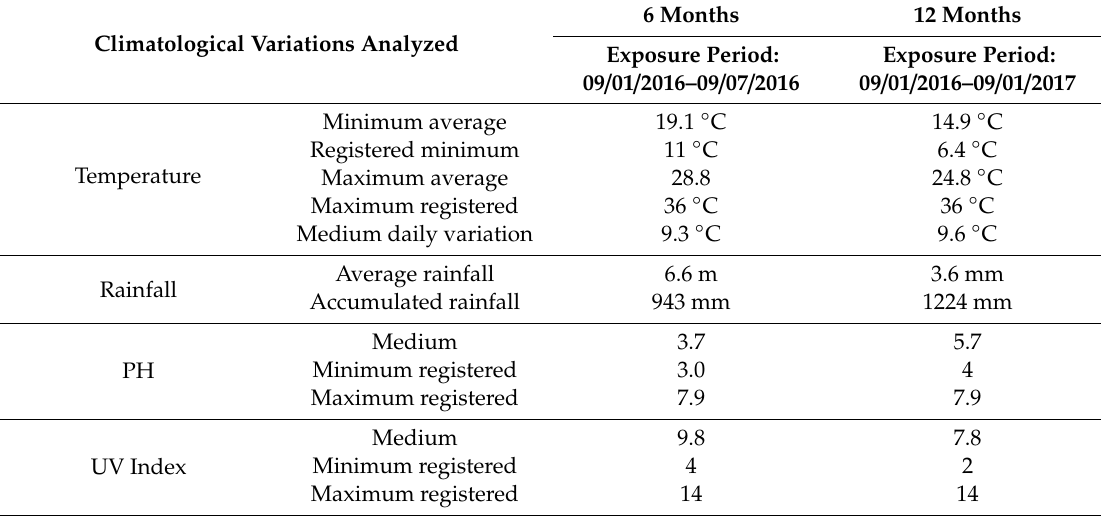
Table 2. Data of the climatological variables analyzed for 6 and 12